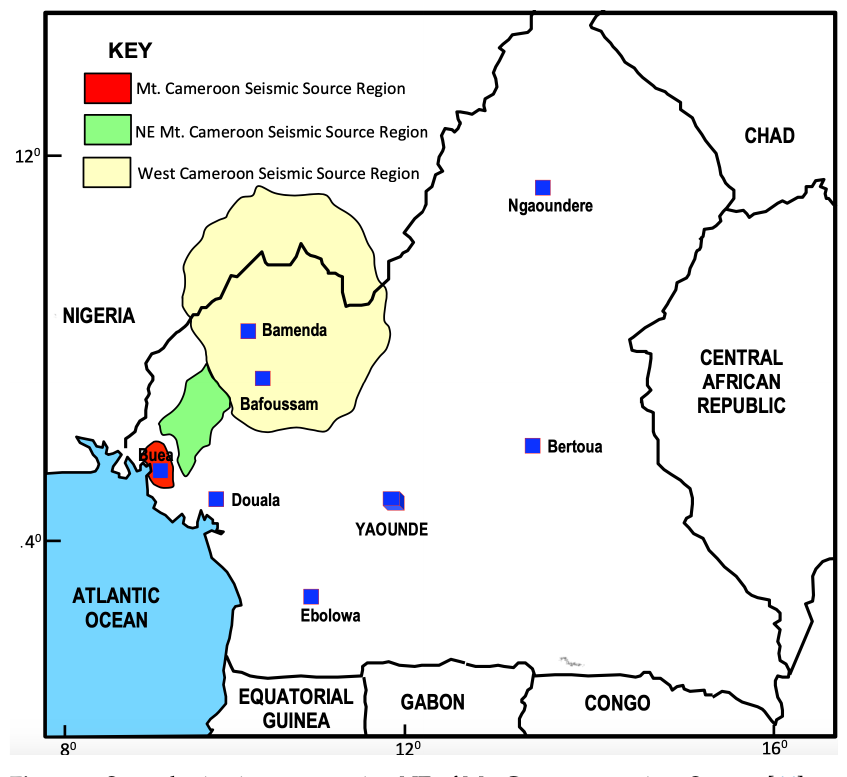
Figure 5. Second seismic source region NE of Mt. Cameroon region. Source: [66]. The third occurs in the central part of the country along the Western Cameroon High- lands. Prominent in this region are Eocene to Pliocene volcanic eruptions, the “ Sanaga Shear Zone ” ( SSZ) (Figure 6) and crater lakes. Seismicity here is diffuse and seismic events have occurred at average depths of 33 kms and the largest recorded earthquakes of 5.8 Mb magnitude has been recorded [12,72,73]. The Fourth SSR occurs along the northern boundary of the Congo Craton (Figure 6) with characteristic magnitude of 6 Mb and 33 km depth. Despite its relatively shallow and weak magnitude earthquakes, arguably, this source region has the potential to generate large earthquakes.